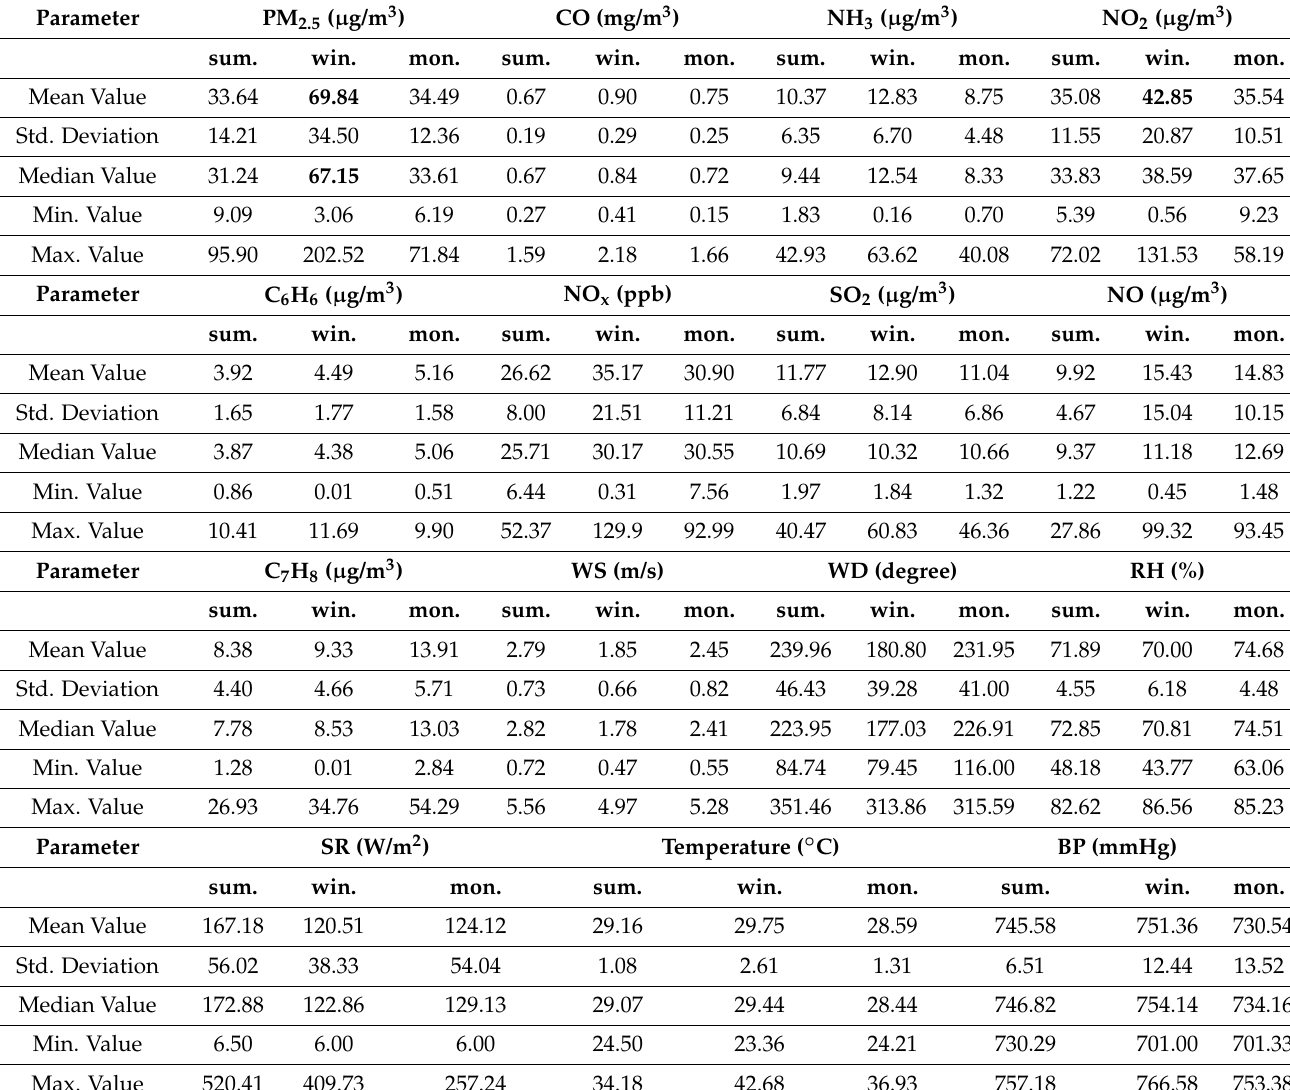
Table 6. Seasonal behavior of PM 2.5 concentration, air pollutants and meteorological parameters during summer season (sum.), winter season (win.) and monsoon season